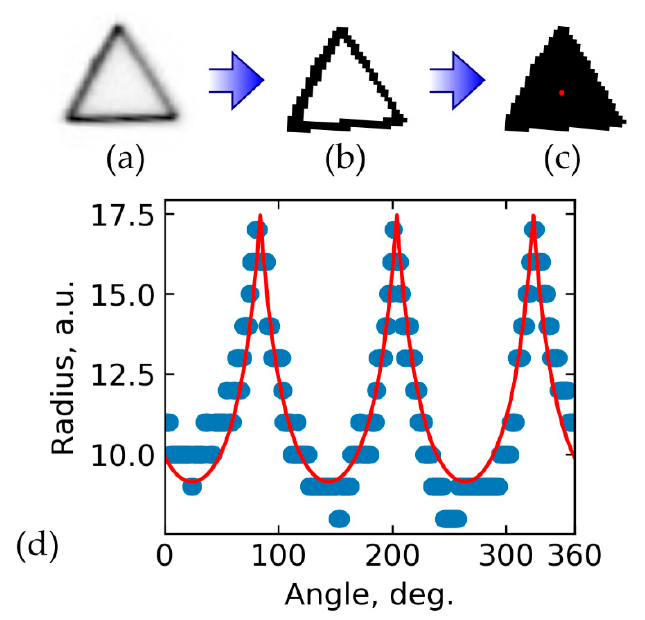
Figure A2. ( a ) An image of the domain walls of the isolated domain. ( b ) Binarized domain walls image. ( c ) Binarized domain image. ( d ) Representation of ( b ) in polar coordinates, solid red line—fitting by Equation (A1).